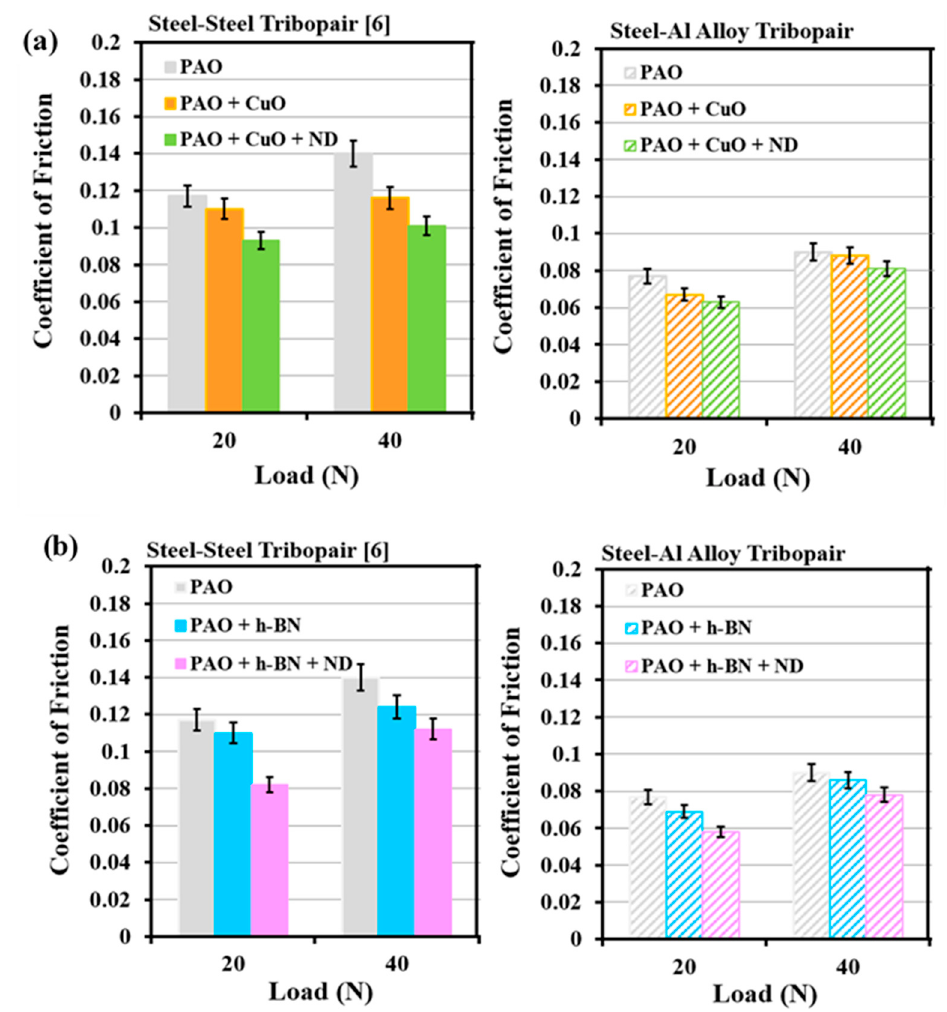
Figure 19. COF of steel–steel tribopair [10] and steel–aluminium tribopair when AISI 52100 steel balls were slid against balls were slid against the discs under: ( a ) PAO, PAO + CuO primary additive/+ ND the discs under: ( a ) PAO, PAO + CuO primary additive/+ ND secondary additive lubricants and ( b ) PAO, PAO + h-BN primary additive/+ ND secondary additive lubricants.